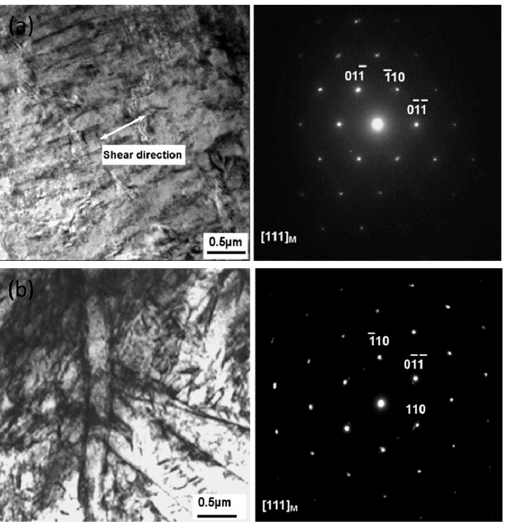
Figure 18. TEM and selected area diffraction (SAD) pattern of ( a ) deformed shear bands and ( b ) transformed shear bands [107] .